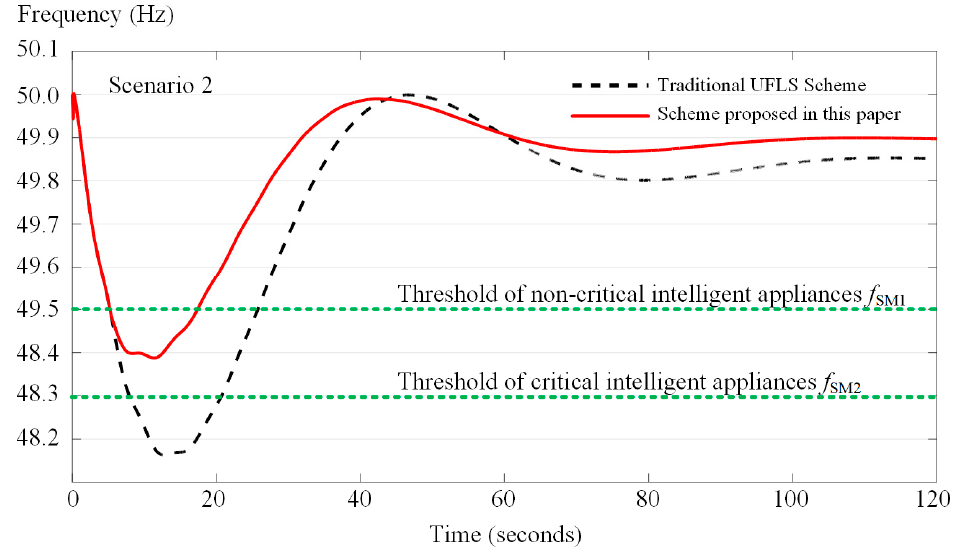
Figure 9. Curves of frequency in Scenario 2 under the three comparison schemes.